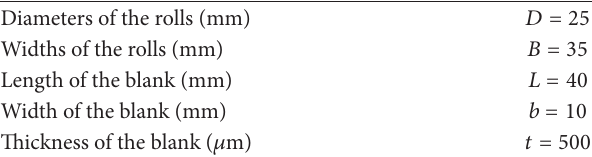
Table 1: Basic geometric parameters of the FE model.